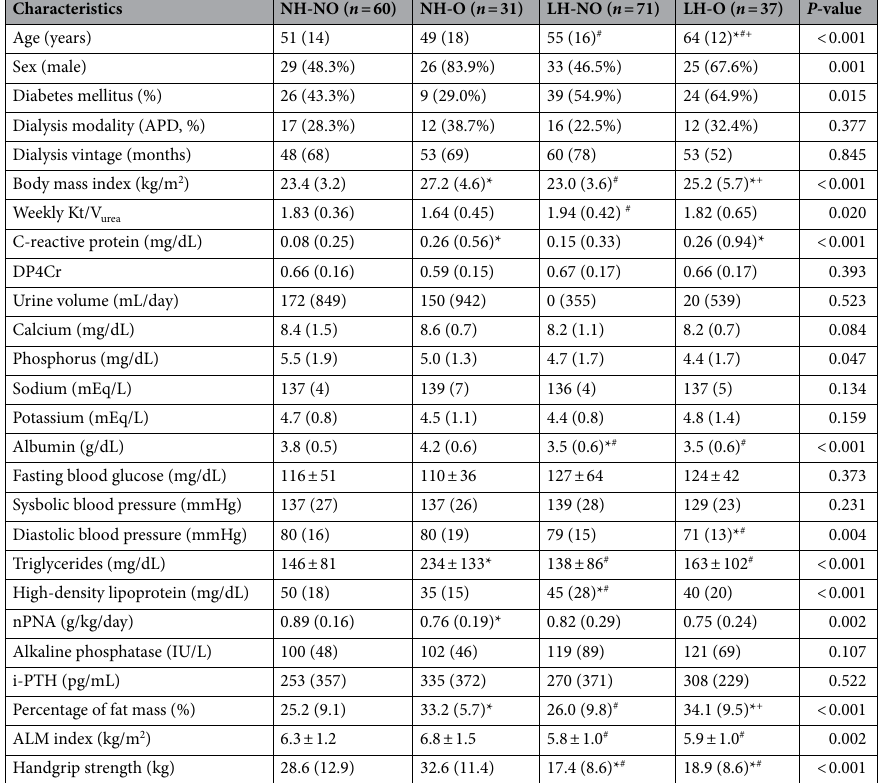
Table 1. Clinical characteristics of participants. Data are expressed as mean ± standard deviation for continuous variables with normal distribution and median (interquartile range) for those without normal distribution. Categorical variables are expressed as number (percentage). P -values were tested among the four groups and analyzed using Kruskal–Wallis test for continuous variables with non-normal distribution and one-way analysis of variance with normal distribution. Bonferroni correction or Turkey comparison were used for post-hoc comparison between two groups. Categorical data were compared using Pearson’s χ 2 or Fisher’s exact test. NH-NO patients with normal handgrip strength and without obesity; NH-O patients with normal handgrip strength and with obesity; LH-NO patients with low handgrip strength and without obesity; LH-O patients with low handgrip strength and with obesity; DP4Cr four-hour dialysate-to-plasma creatinine concentration ratio; nPNA normalized protein equivalent of total nitrogen appearance; i-PTH intact parathyroid hormone; ALM appendicular lean mass. * P < 0.05 vs NH-NO # P < 0.05 vs NH-O + P < 0.05 vs.